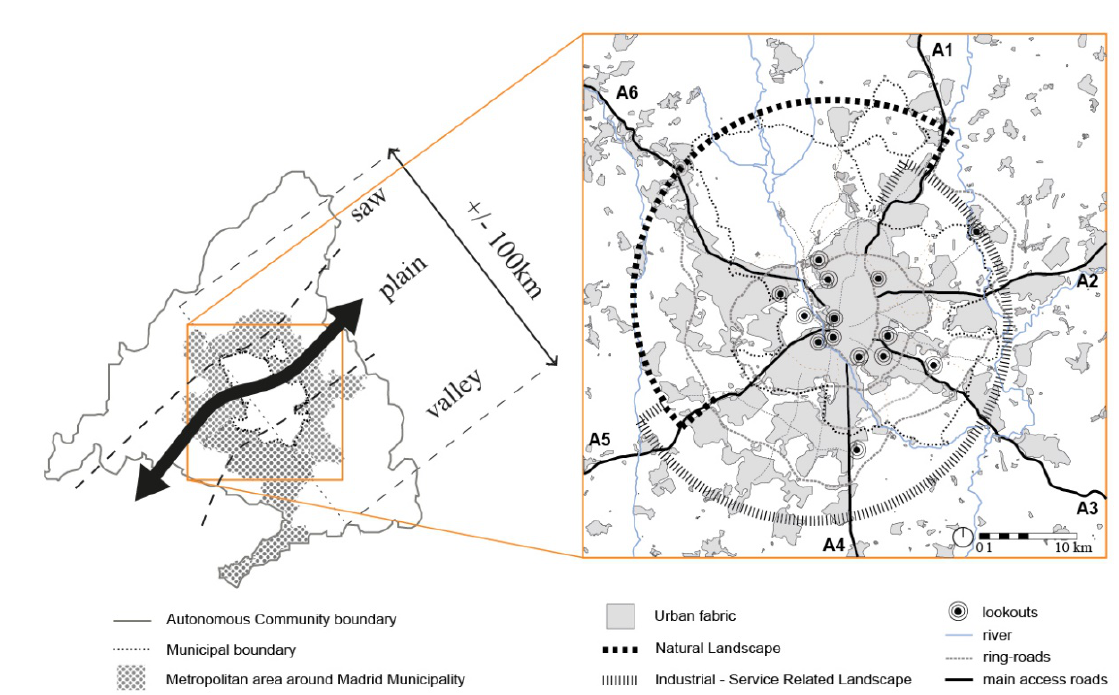
Figure 12: Southwest-northeast ‘diagonal’ dividing the main two landscape types in Madrid, at a regional scale (left) and at a metropolitan scale